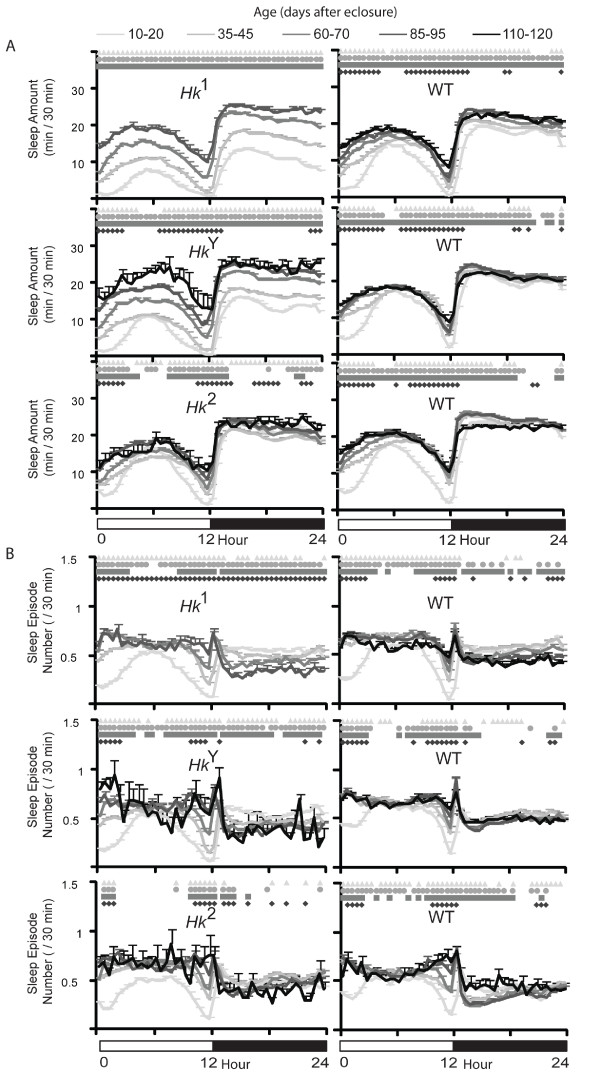
Time course of sleep parameters in all flies. Values are mean + SEM (eleven 30-min intervals averaged per each fly, and then averaged across all flies). Comparisons (Friedman test followed by Wilcoxon signed-rank test, p < 0.05) are between the 10-20 day period and all following ages: triangle (vs 35-45), circle (vs 60-70), square (vs 85-95), diamond (vs 110-120). Data are derived from the same flies described in Figures 2 and 3.